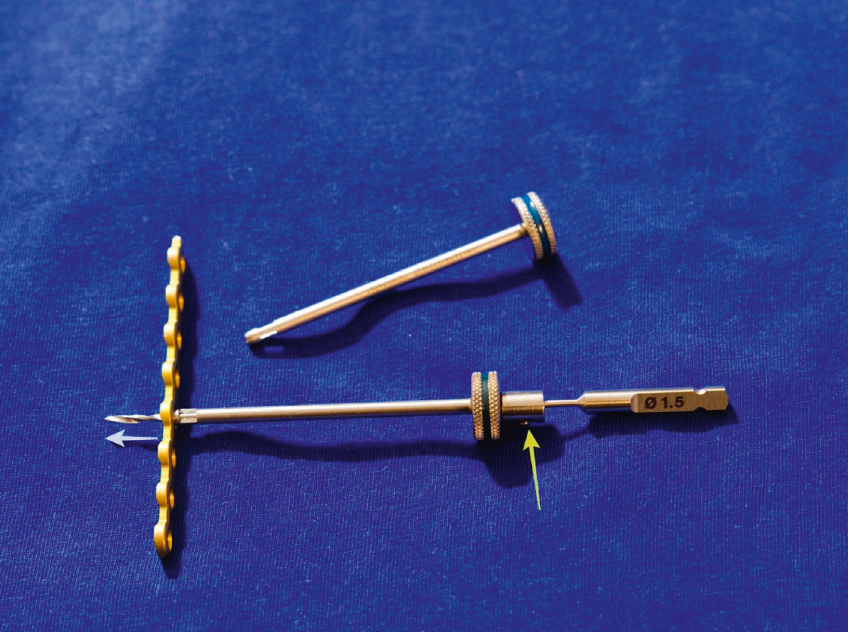
Figure 4: Photograph of plate and drill stop system showing drill stop mounted on 1.5mm drill bit (yellow arrow) and predefined depth of drilling (white